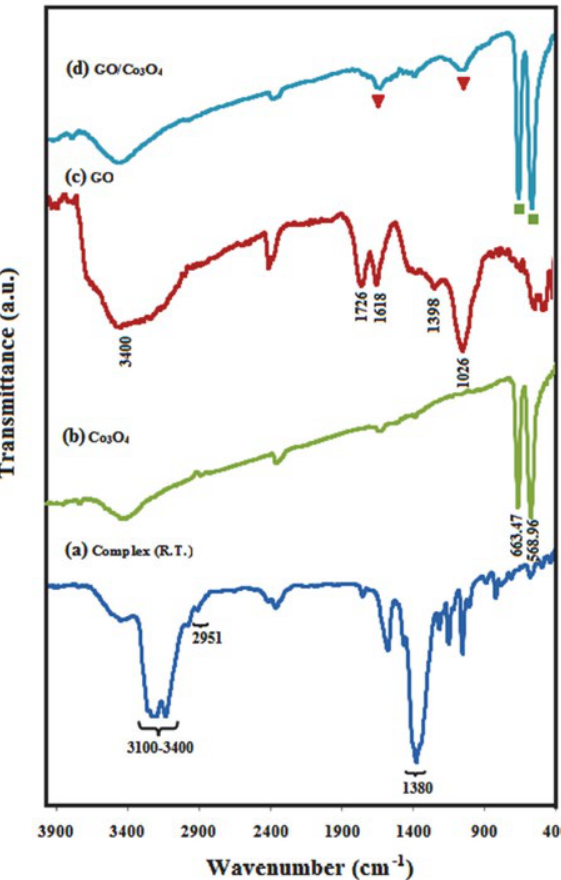
Figure 1. FT-IR spectra of (a) [Co(en) (c) GO, and (d)